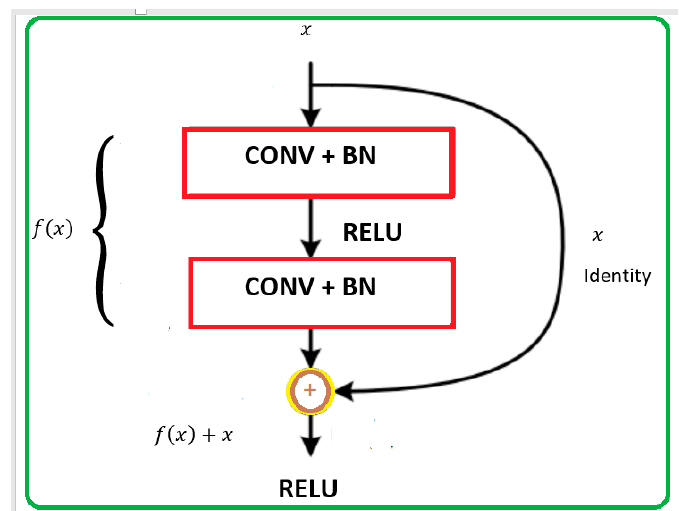
Figure 12. ResNet: A building block.